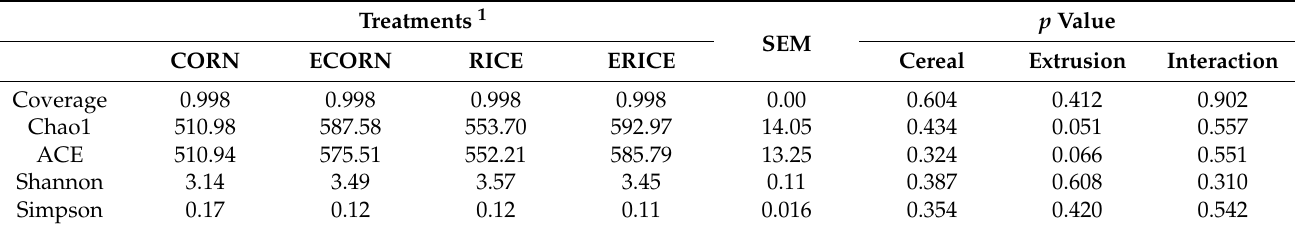
Table 9. The alpha diversity of fecal microbiota.